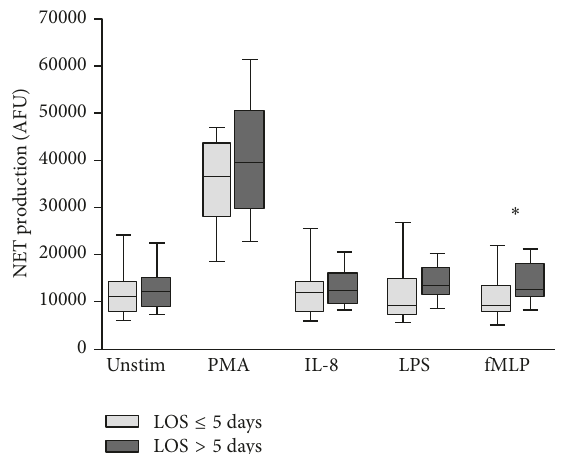
Figure 4: Box-and-Whisker plot (10th–90th percentile) of NET production in patients who had length of stay ≤ 5 days ( 𝑛 = 9 ) versus lengthofstay > 5days( 𝑛 = 35 )inresponsetonostimulant(Unstim), PMA, IL-8, LPS, and fMLP. Statistical significance, measured by Mann–Whitney 𝑈 test, is denoted by ∗ 𝑝 < 0.05 .